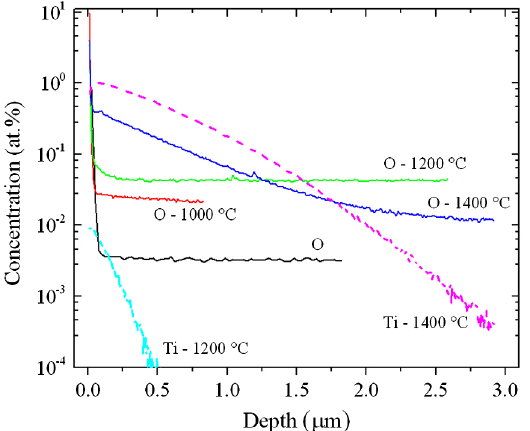
FIG. 14. Oxygen concentration measured in the reference, non- heat-treated, sample L35 (black line), sample L40 heat treated at 1000 (cid:1) C (red line), sample L48 heat treated at 1200 (cid:1) C (green line), and sample L51 heat treated at 1400 (cid:1) C (blue line). Also shown is the titanium concentration measured in samples L48 (cyan dashed line) and L51 (magenta dashed line).